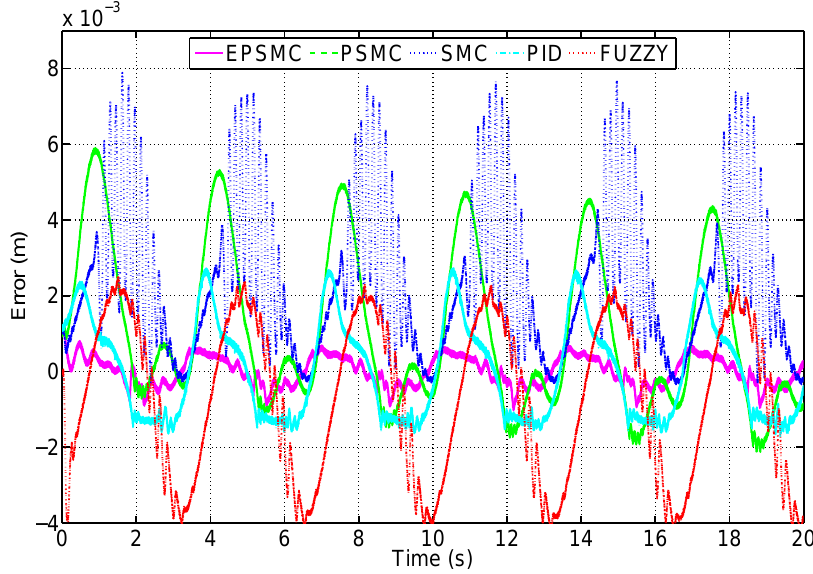
Figure 5. The tracking error of the